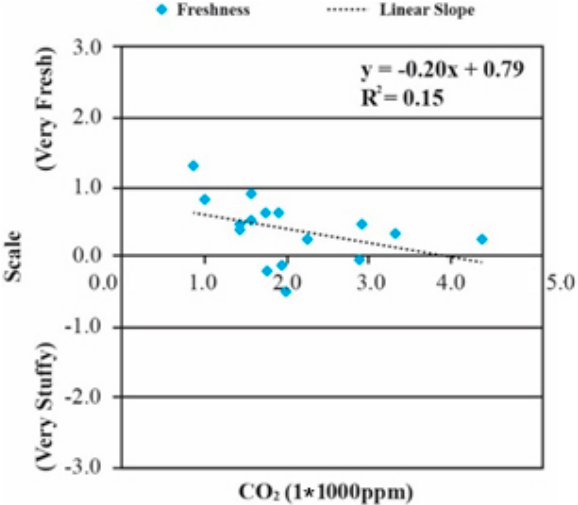
Figure 6. The perception of freshness according to the CO 2 concentration.